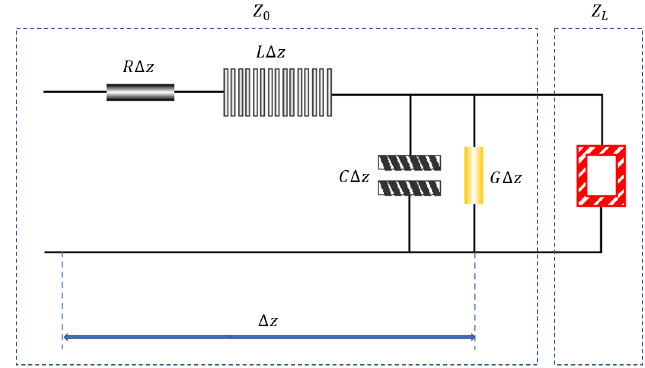
Figure 2. The principle of impedance matching.